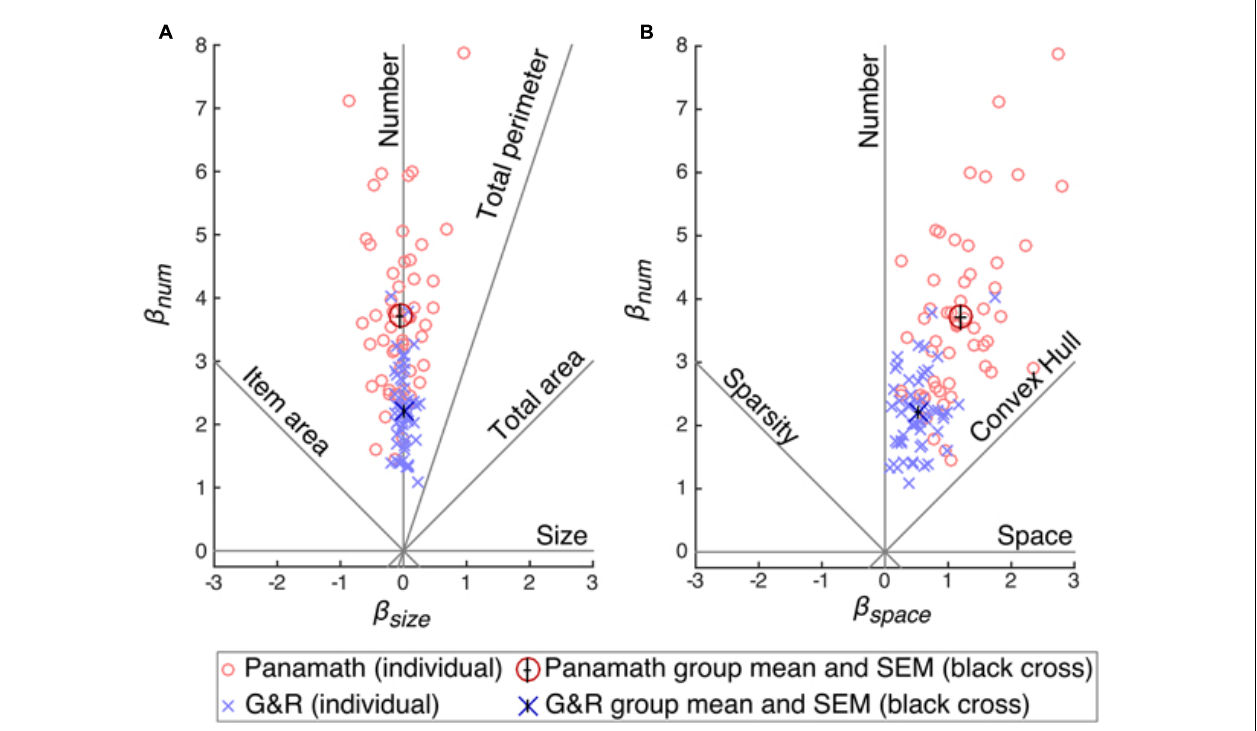
FIGURE 4 | Coefficient space reveals differences in acuity and bias between protocol. Model coefficients were calculated for each participant separately for each condition and plotted against each other: β num × β size (A) and β num × β space (B) . Red circles show coefficients calculated from Panamath trials and blue “ × ”s from G&R. The larger and darker red circle and blue “ × ” show the means for each protocol, and the small black cross in the center of these symbols indicates the SEM. Acuity is equivalent to the height of a point and bias is indicated by its deviation from the vertical “Number” feature line.